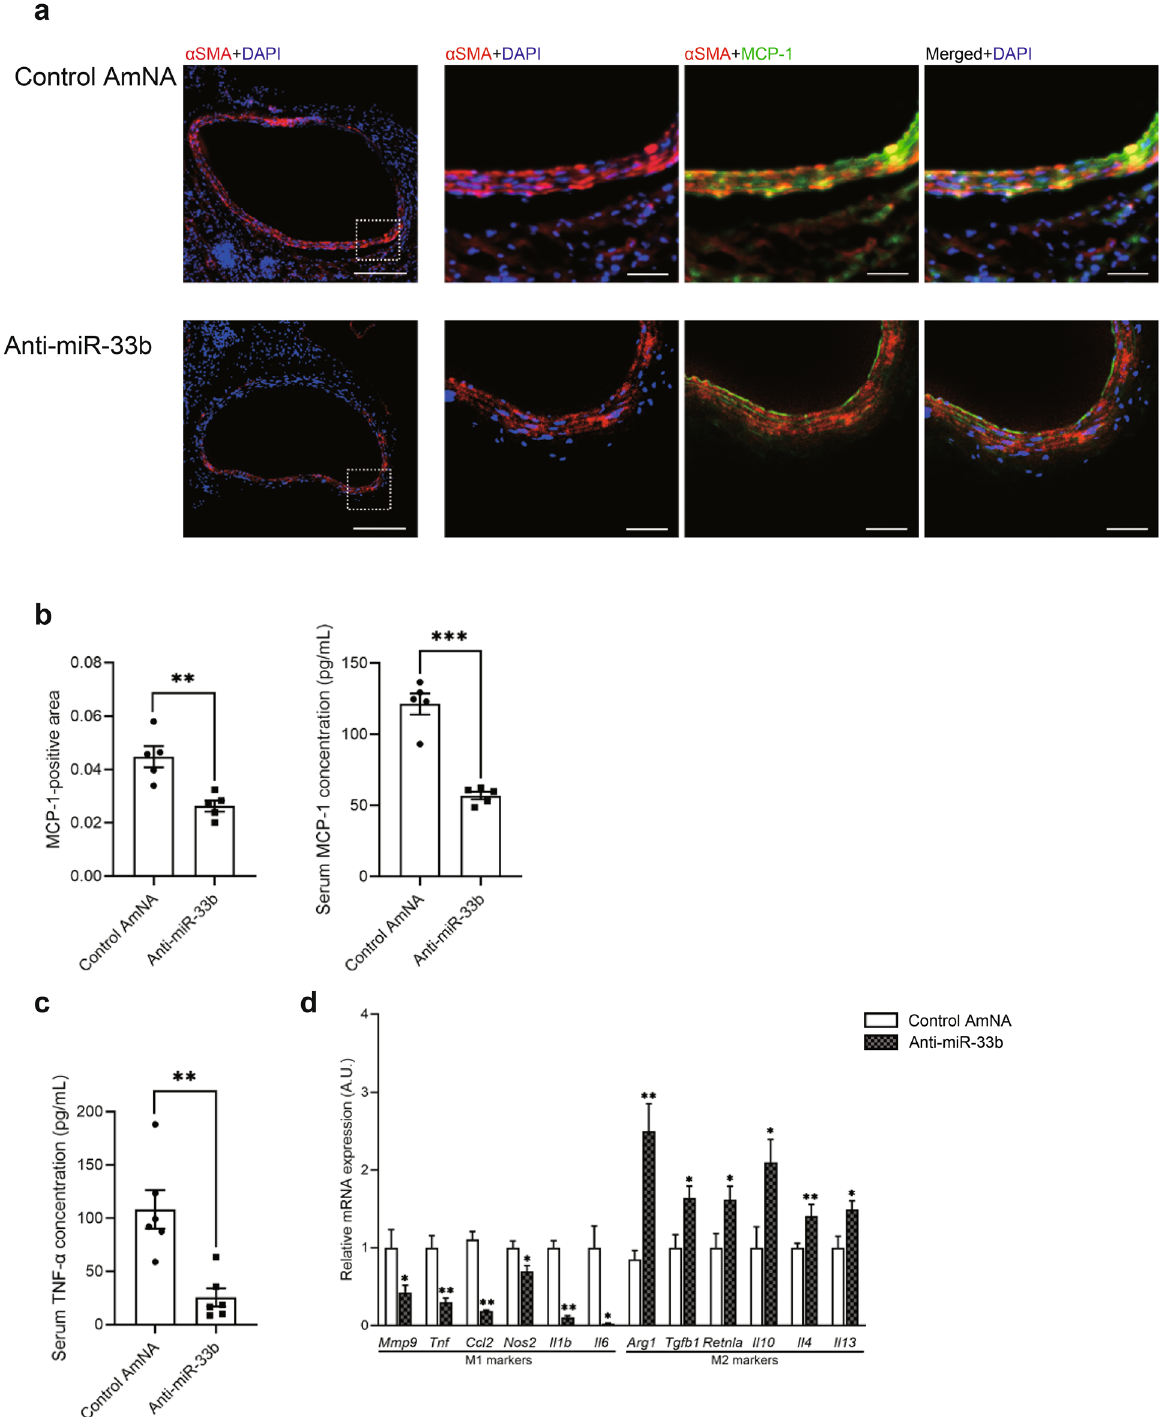
Figure 7. Inhibition of miR-33b in miR-33b KI mice prevents the secretion of MCP-1 and conserves the structure of VSMCs. ( a ) Representative images of immunofluorescence staining for αSMA (red), MCP-1 (green), and DAPI (blue). Scale bar indicates 200 µm for low power-field and 50 µm for high power-field. ( b ) Quantification of the MCP-1-positive area in sections of the CaCl 2 -induced AAA wall (left) and serum MCP-1 concentration using an enzyme-linked immunosorbent assay (right), n = 5 mice for immunofluorescence staining and enzyme-linked immunosorbent assay. Unpaired two-tailed t test (left and right). **P < 0.01 and ***P < 0.001. ( c ) Serum TNF-α concentration of CaCl 2 -induced AAA mice with administration of the indicated AMOs, n = 6 mice in each group. Unpaired two-tailed t test. **P < 0.01. ( d ) Real-time PCR analysis of classical M1 and M2 markers of CaCl 2 -induced AAA mice with administration of the indicated AMOs, n = 6 mice in each group. Unpaired two-tailed t test ( Mmp9 , Tnf , Ccl2 , Nos2 , Arg1 , Tgfb1 , Retnla , Il10 and Il13 ) and Mann– Whitney test ( Il1b , Il6 and Il4 ). *P < 0.05 and **P < 0.01. All data represent mean ±